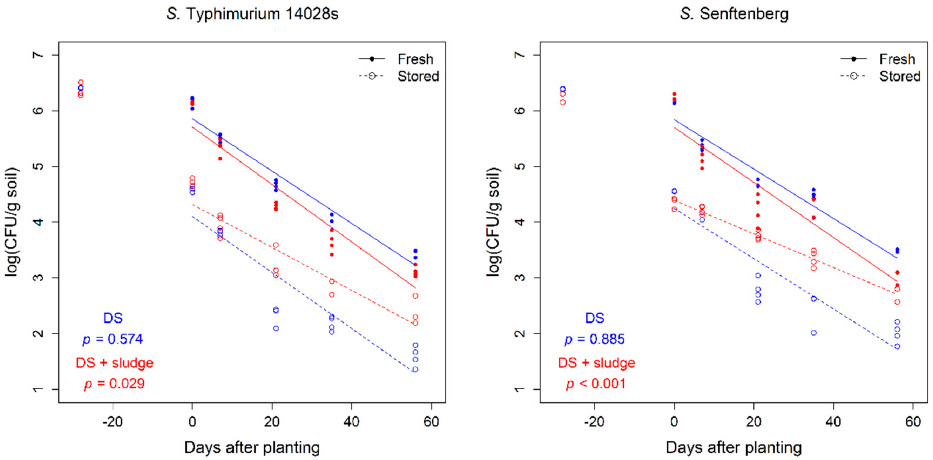
Figure 4. Colony forming unit (CFU) counts and persistence dynamics of Salmonella enterica in DS soil. A decrease in CFU counts of S . Typhimurium 14028s and S . Senftenberg per g dry soil with or without sewage sludge compost amendment are shown. All experimental variants were performed in quadruplicates and CFU counts were assessed by dropping duplicates of duplicate serial dilutions on XLD plates supplemented with rifampicin (50 mg / L). The dynamics of Salmonella persistence in DS soil according to entry route, soil treatment and serovar are expressed as linear regressions. Salmonella was applied either 28 days before planting (“stored”) together with the sludge (DS + sludge) or without sludge (DS) or immediately before planting on day 0 (“fresh”). The decrease rates between fresh and stored treatments were compared for soil amended with and without sludge by linear modeling and p values below 0.05 indicate a significant di ff erence. Due to the imbalanced design (day –28 only for the “stored” treatment) only days 0 until 56 were included in the